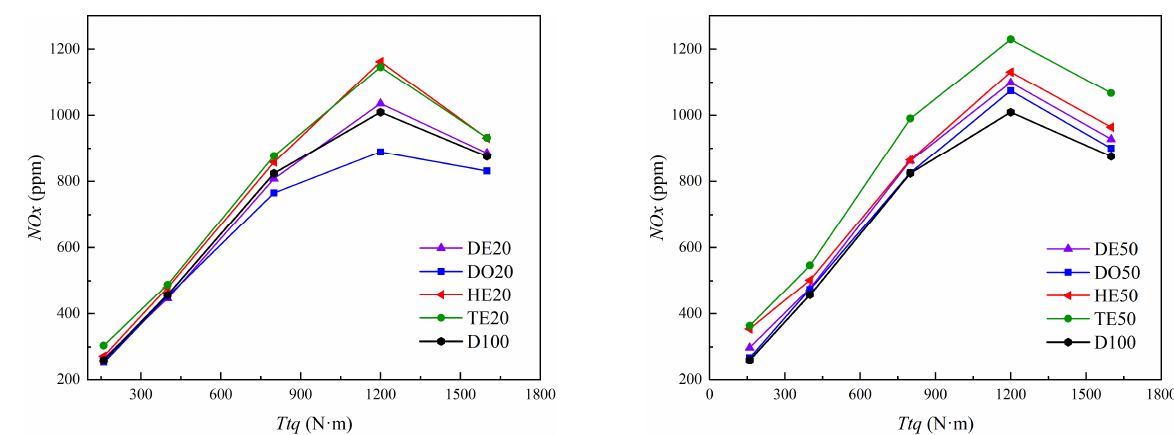
Figure 13. NOx emissions versus engine loads at 1900 rpm.